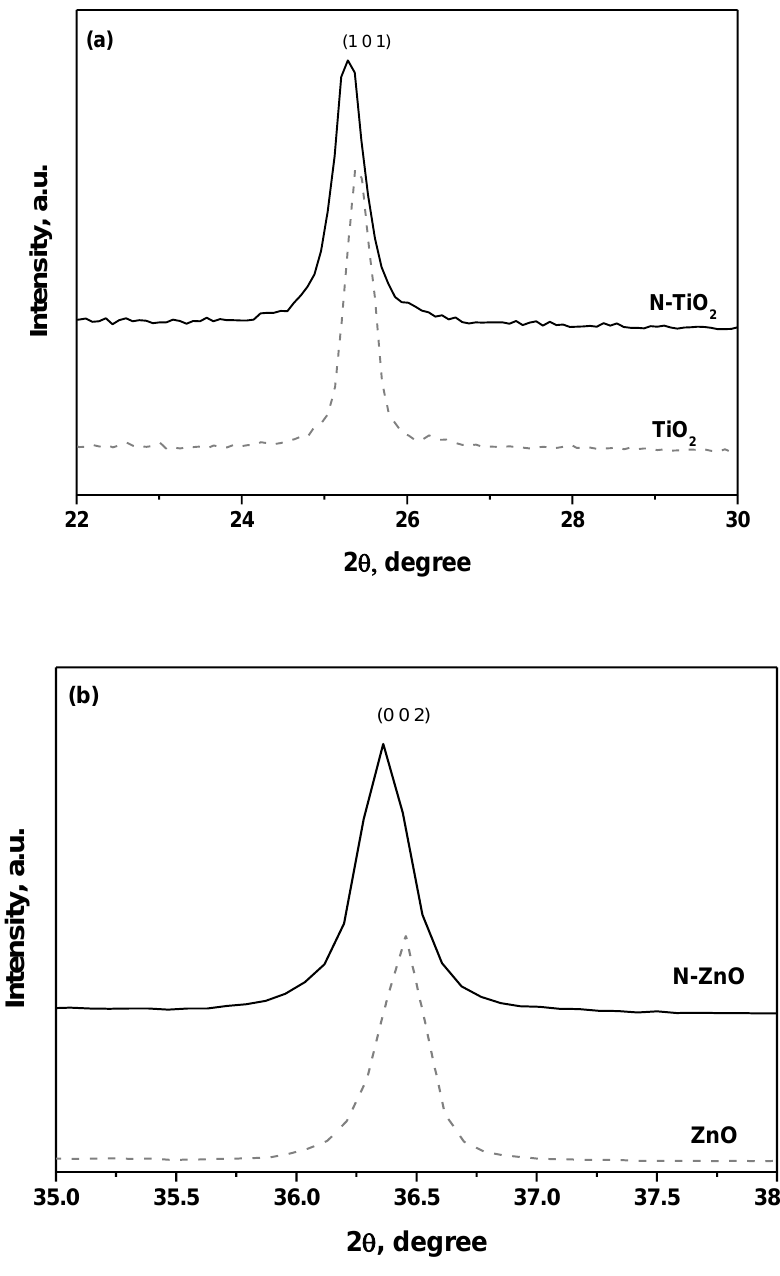
Figure 5. WAXD patterns for ( a ) TiO 2 and N-TiO 2 in the range of 22 – 30° and for ( b ) ZnO and N-ZnO samples in the range of 35 – 38°.